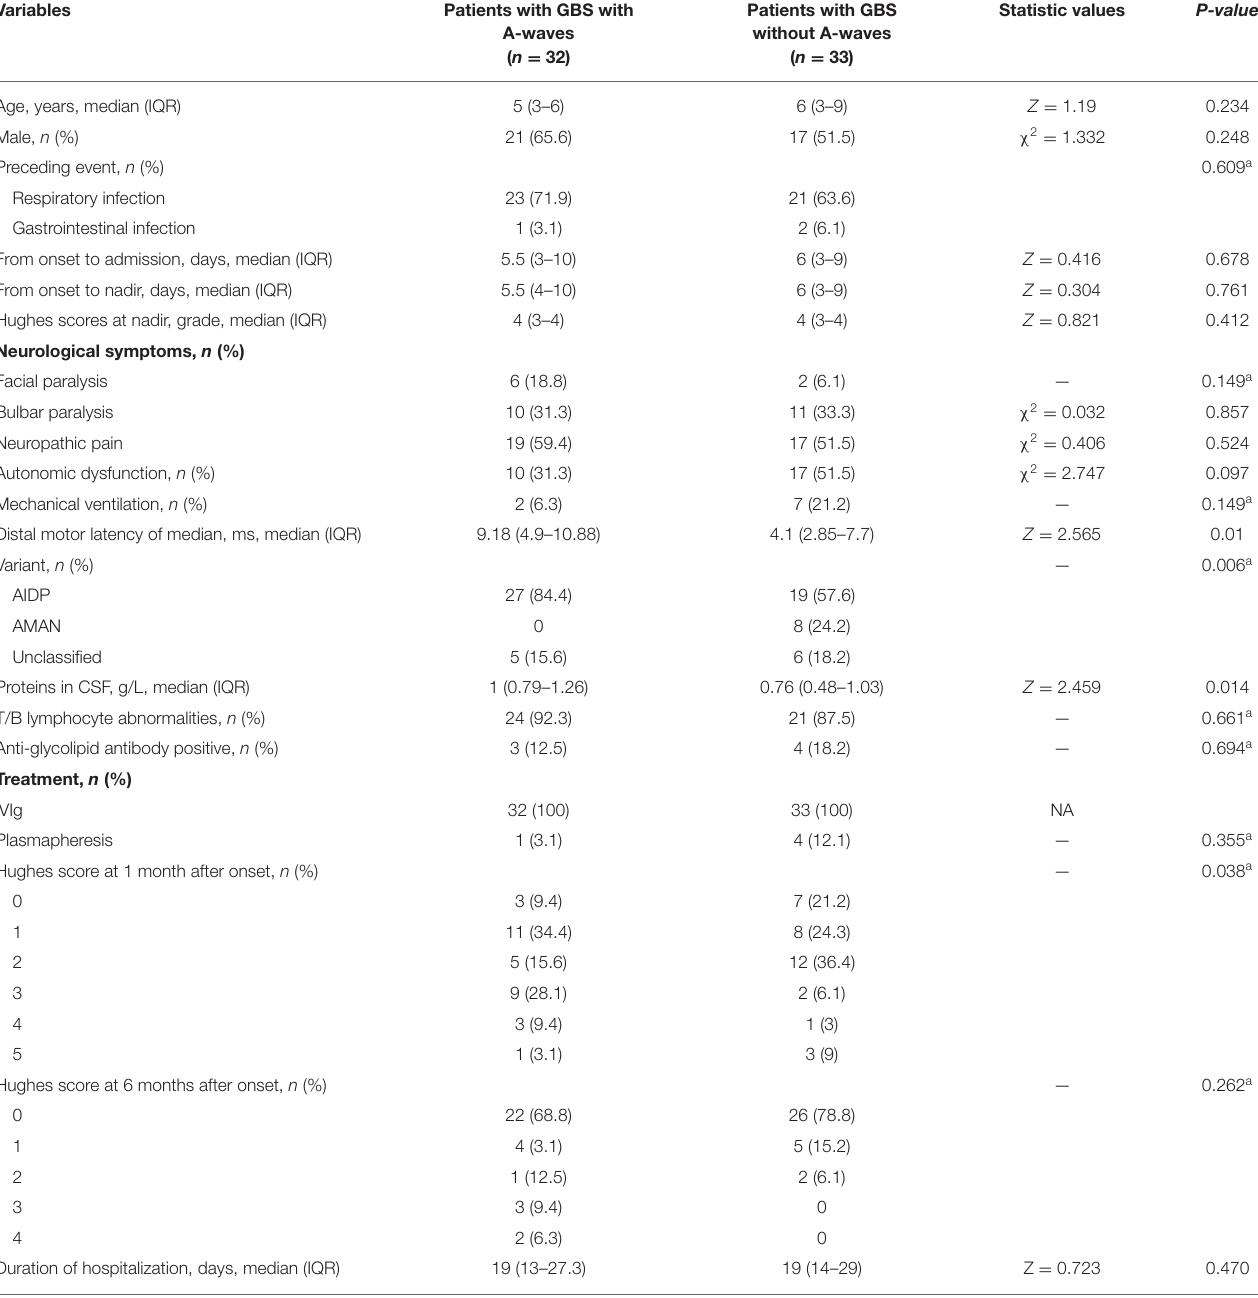
TABLE 1 | Clinical and electrophysiological data in pediatric Guillain-Barré syndrome (GBS). Variables Patients with GBS with